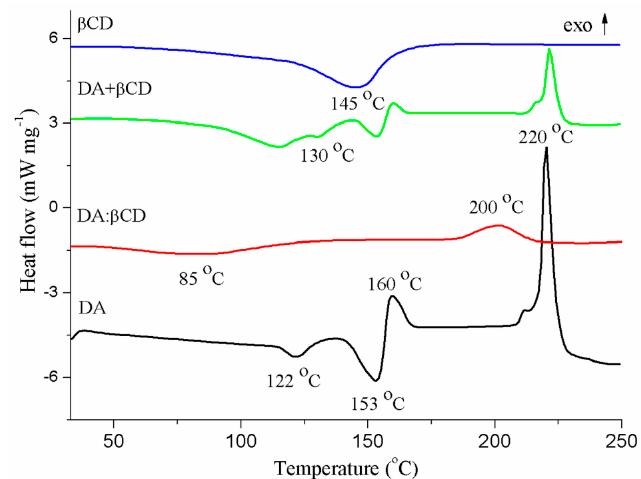
Figure 3. DSC curves of the DA, β CD, and the DA: β CD inclusion complex and DA + β CD (1:1 molar ratio) physical mixture.